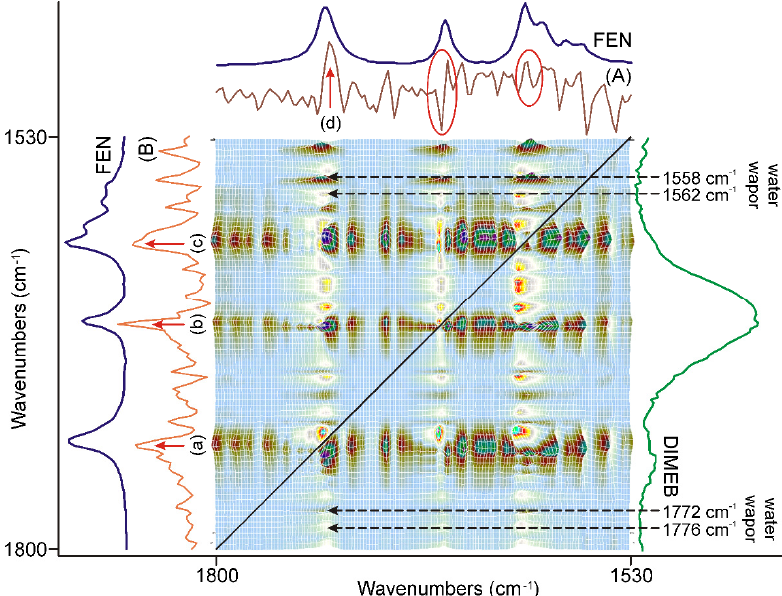
Figure 5. The asynchronous correlation surface of the first 20 min of grinding, between 1800 and 1530 cm − 1 , had axial symmetry to the diagonal black line. Some unexpectedly strong correlation occurred outside these regions, some marked by black broken arrows, on both sides of the diagonal line and they were attributed to the residues of water vapor bands. On the other hand, (A) the x-axial section of the surface at 1732 cm − 1 , and (B) the y-axial section of the surface at 1726 cm − 1 indicated strong changes in the ranges of the characteristic bands of FEN: (a) at 1732 cm − 1 , (b) at 1653 cm − 1 , (c) at 1600 cm − 1 , and (d) at 1726 cm − 1 . In the case of (B), the other two characteristic bands were impossible to identify due to the interference of water vapor peaks, marked with a red ellipsis.